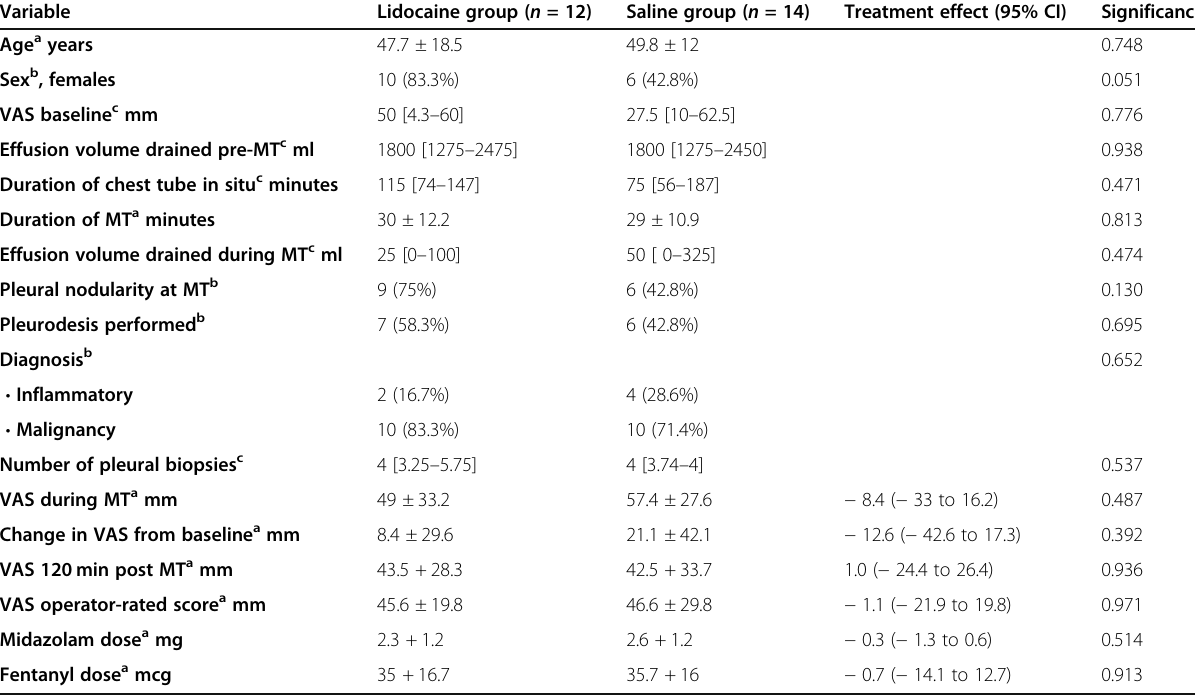
Table 1 Baseline characteristics, procedural details, and study outcomes in the treatment groups of the